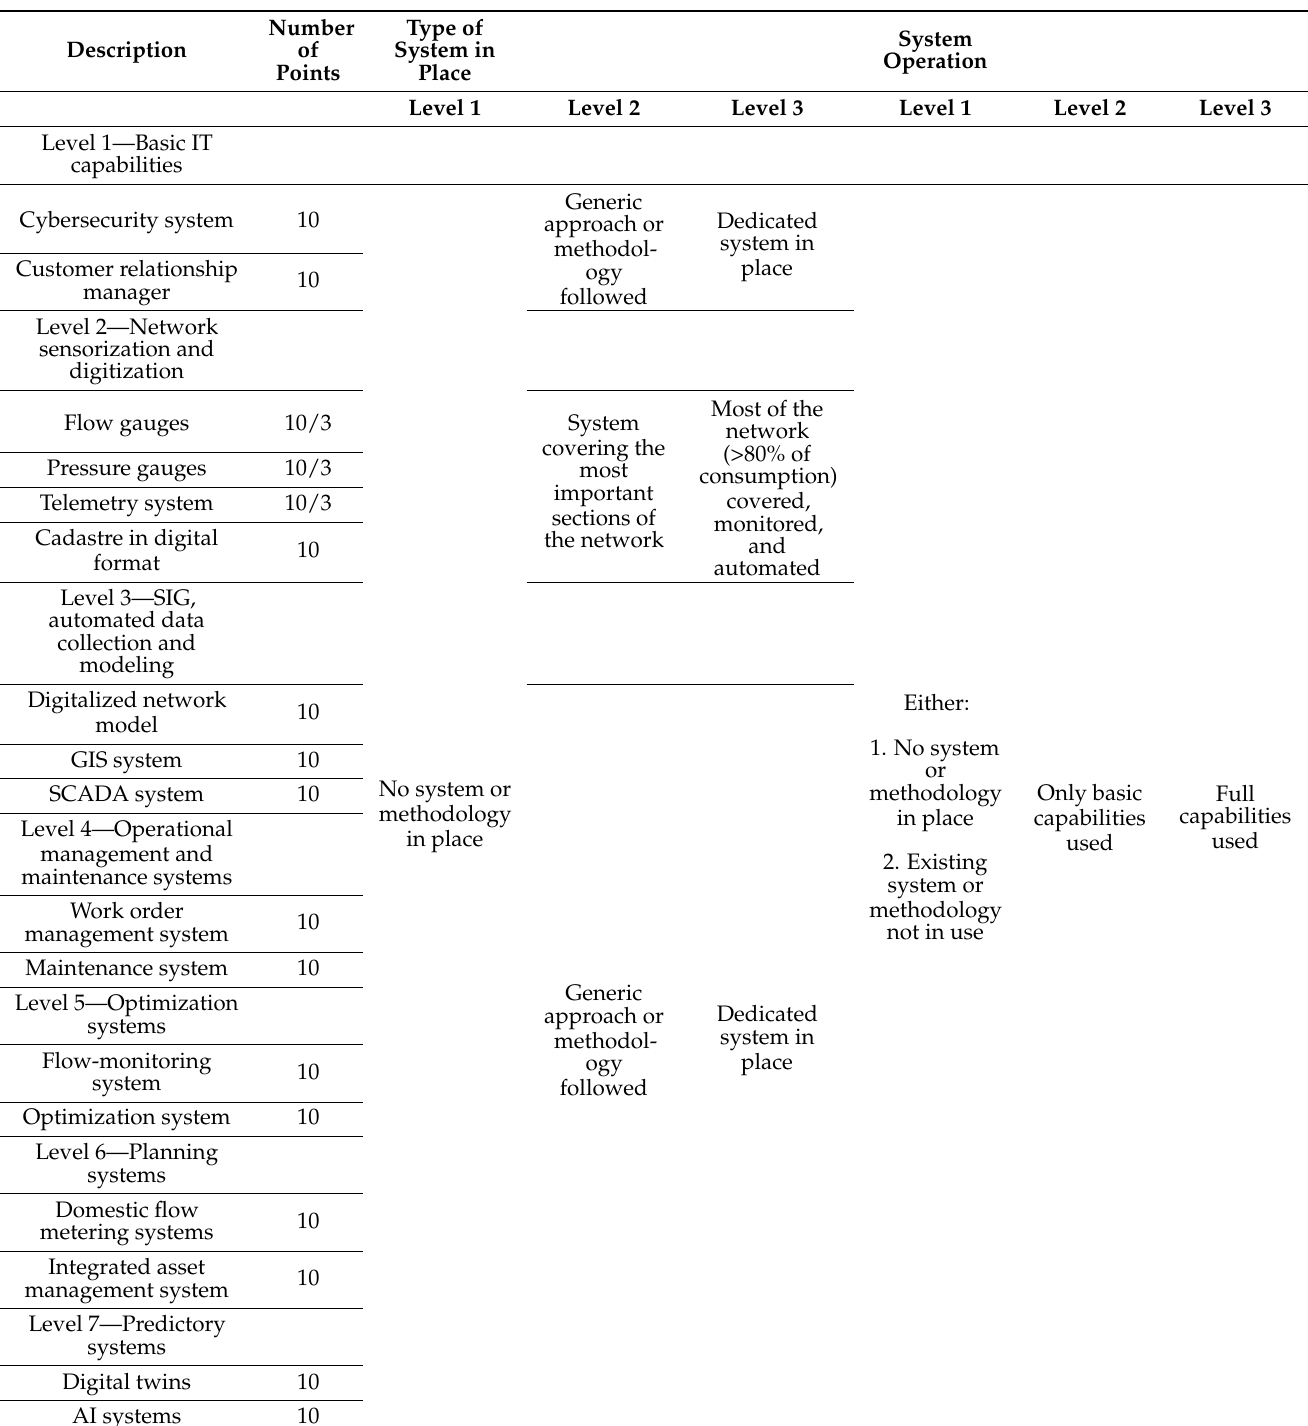
Table 2. Matrix used to determine digital maturity for a water